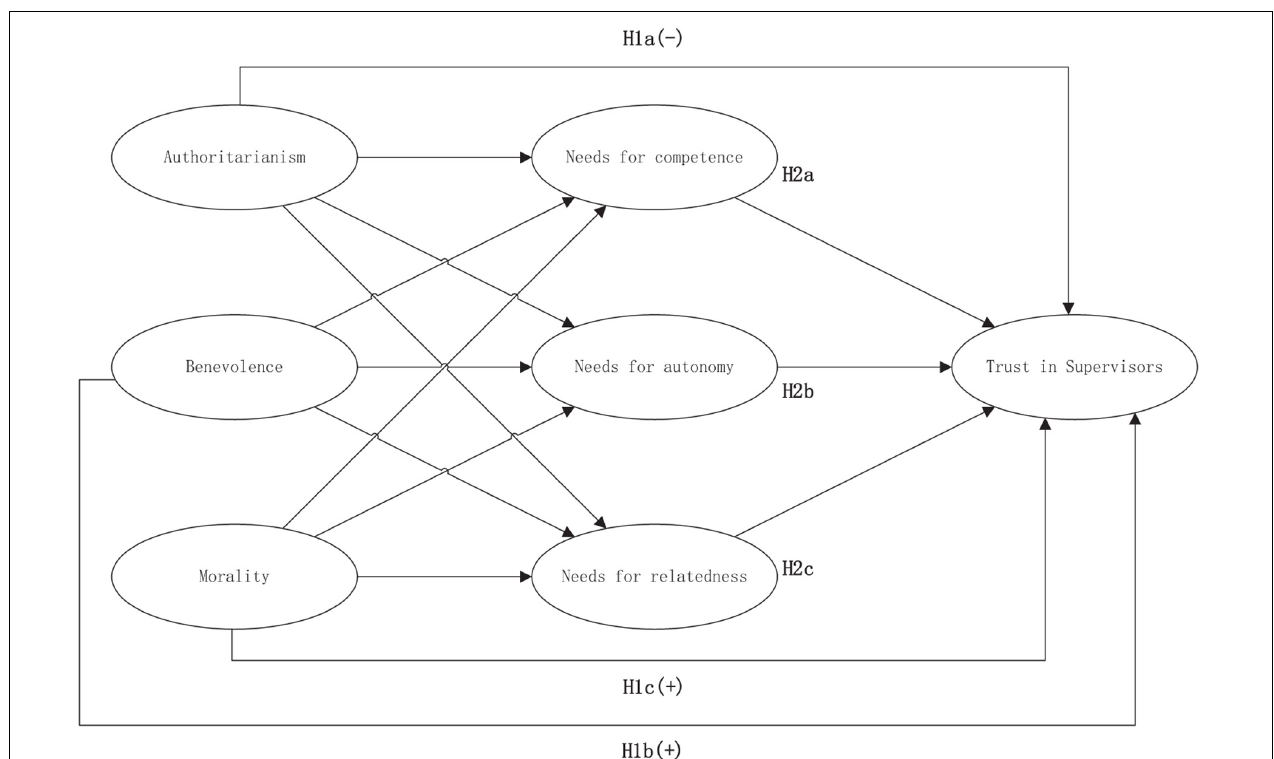
FIGURE 1 | Research